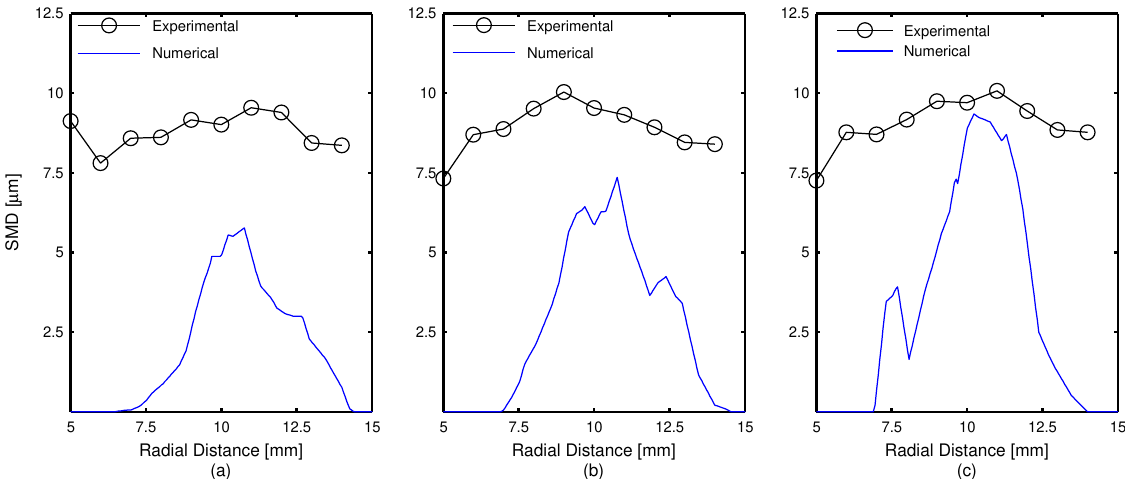
Figure 8. Numerical radial SMD profile comparison with experimental PDI data from GM for the baseline condition (G1). ( a ) 0.3ms, ( b ) 0.6ms and ( c ) 0.9ms.